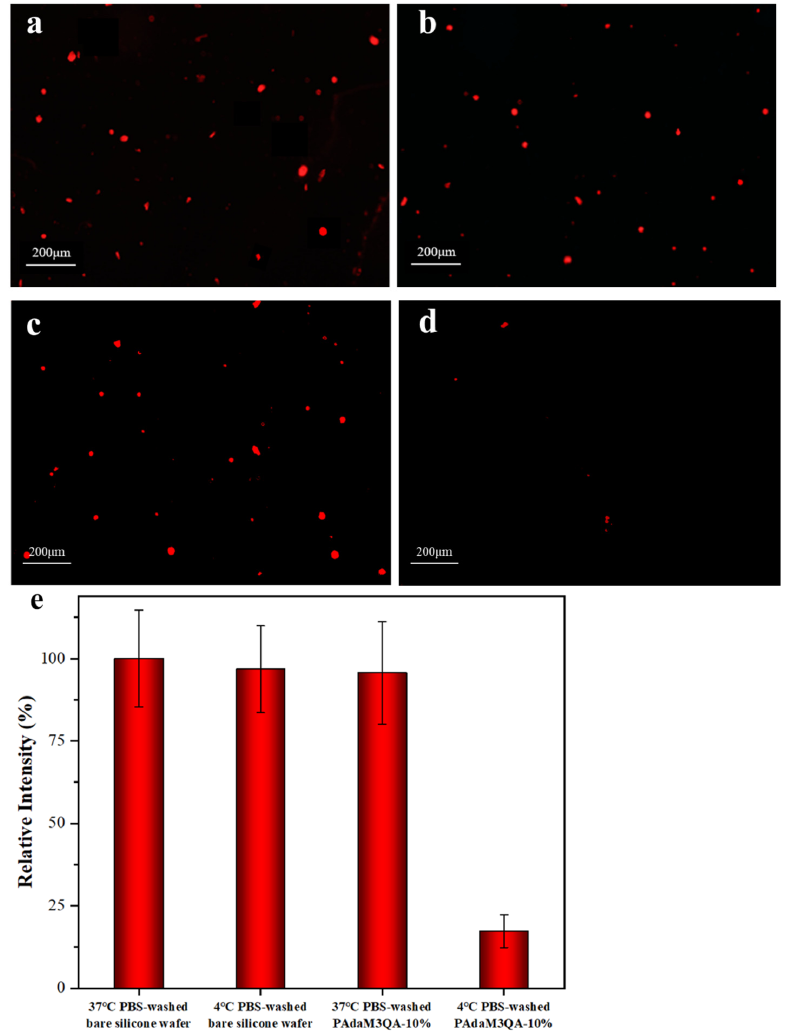
Figure 10. Fluorescent images of BSA adhered on ( a ) 37 ◦ C and ( b ) 4 ◦ C PBS-washed bare silicon wafers, ( c ) 37 ◦ C and ( d ) 4 ◦ C PBS-washed PAdaM3QA − 10% coatings, and ( e ) comparison of antifouling performances of bare silicon wafers and PAdaM3QA − 10% coatings.